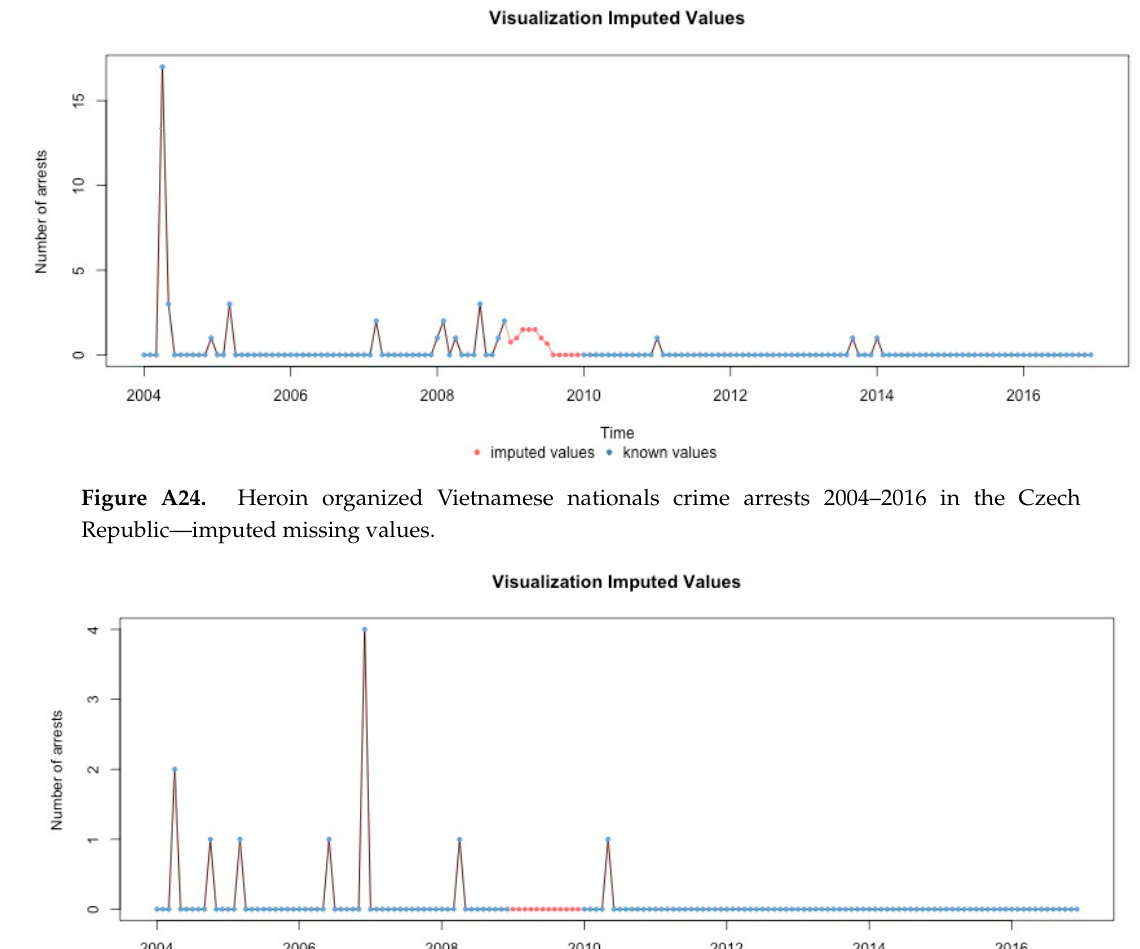
Figure A23. Heroin organized foreign nationals crime arrests 2004–2016 in the Czech Republic – imputed missing values.